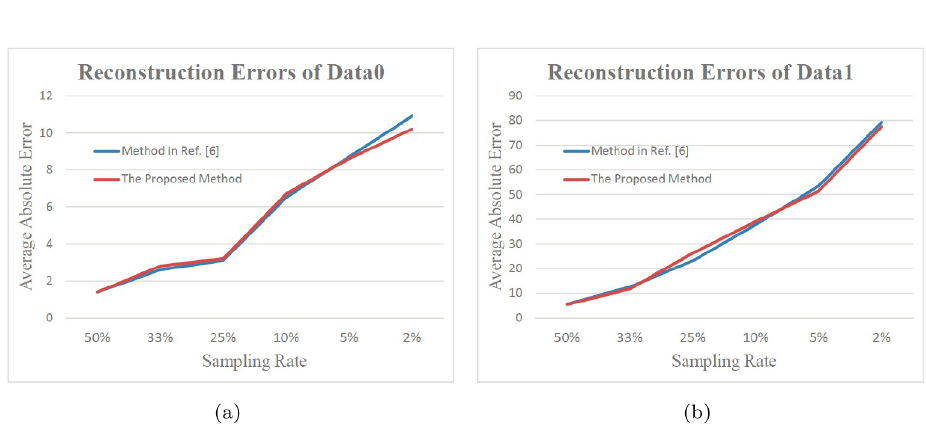
Fig 10. Comarison with the classic method of [7]. (a) shows the reconstruction errors of Data0 in cases of different sampling rates, (b) is related result of Data1. According to them, the accuracy of SVD based method is very close to and a little higher than that of Geodesic based method in [7]. Yet, its computation efficiency is about five times of the latter.